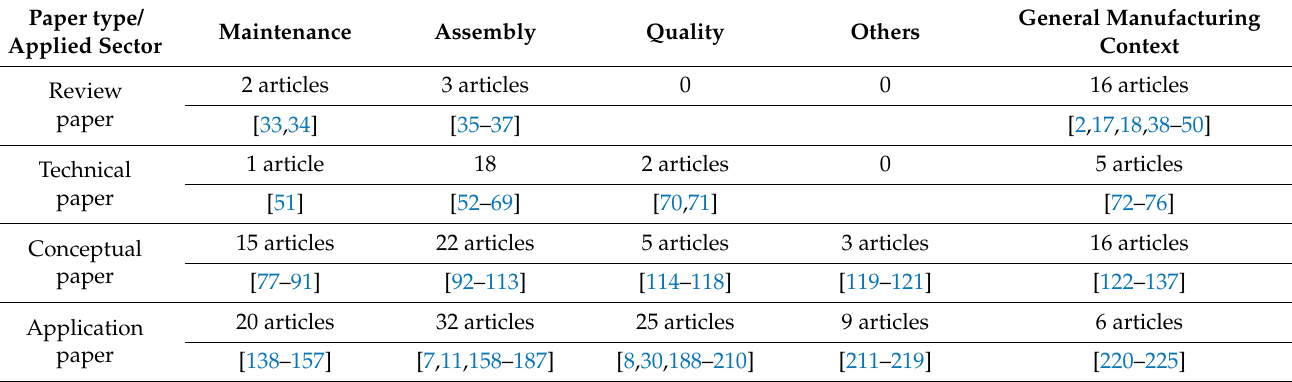
Table 5. Literature retrieved and organized based on the classification